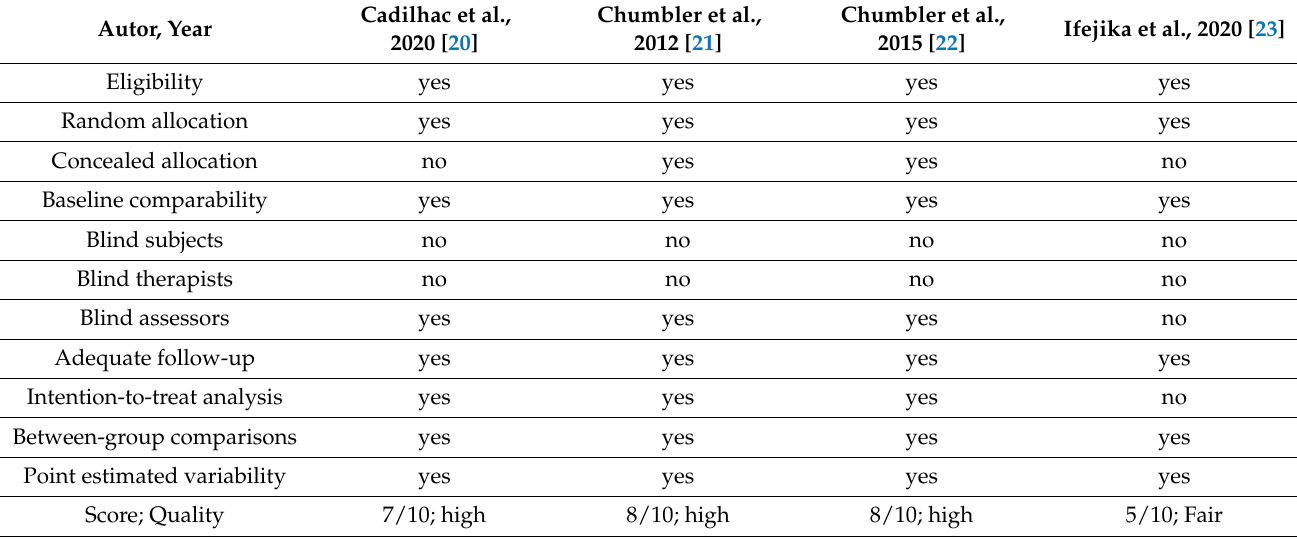
Table 1. Summarized results of the quality assessment for RCT literatures using PEDro scale. Autor, Year